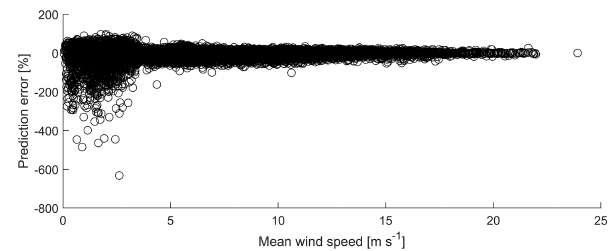
Figure 6. Wind speed against prediction